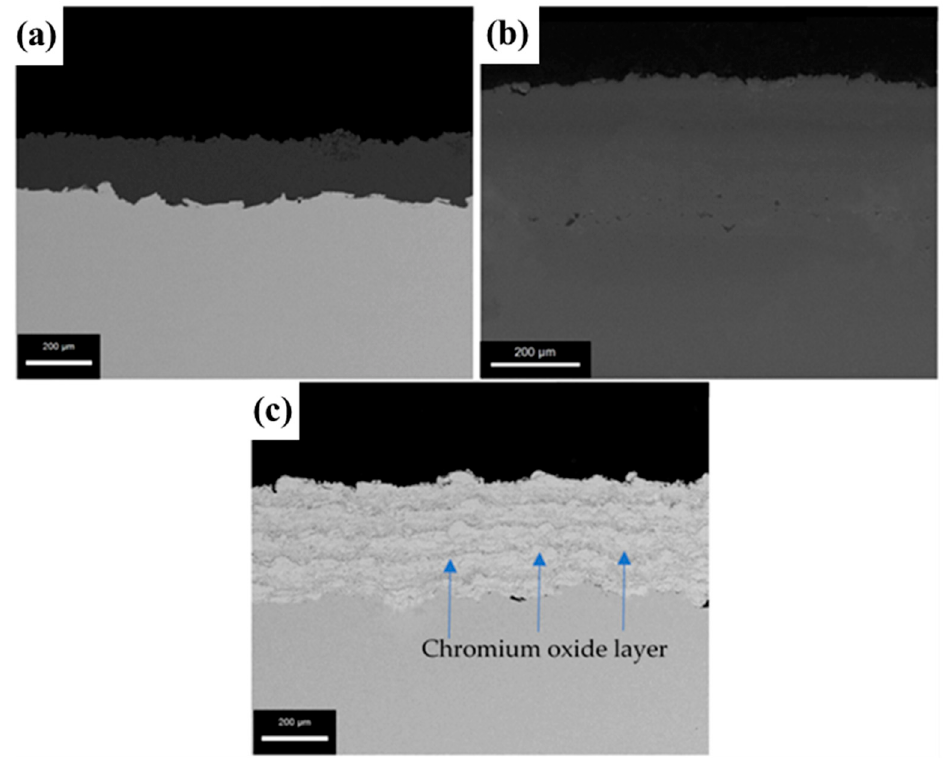
Figure 3. Scanning electron micrographs of ( a ) Al, ( b ) Colmonoy, and ( c ) Inconel coatings.